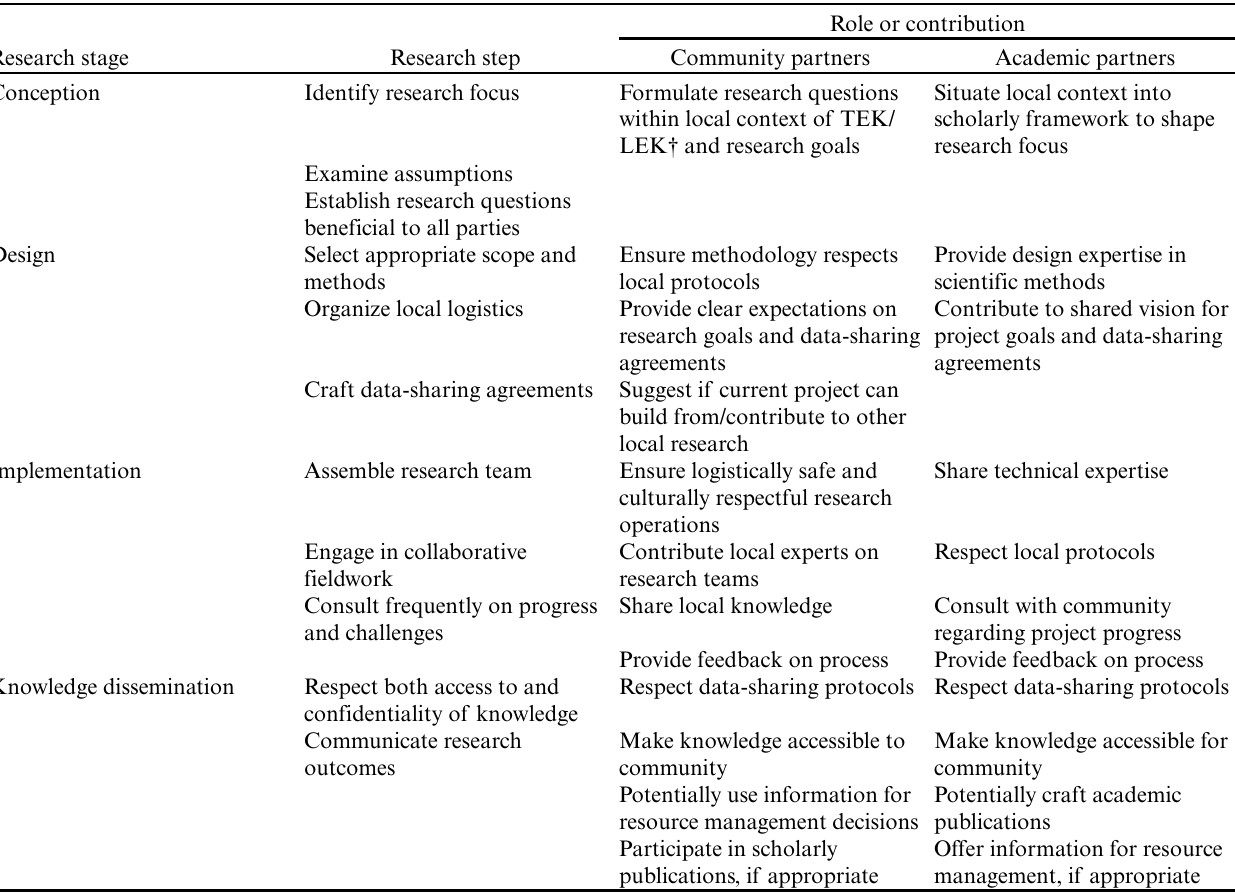
Table 1. Roles and contributions by community and academic collaborators at the conception, design, implementation, and dissemination stages of community engaged research. This is a nonexclusive suite of possible roles; in practice, collaborations might take different forms. We recognize that community members might also be academics, but for simplicity, we identify binary